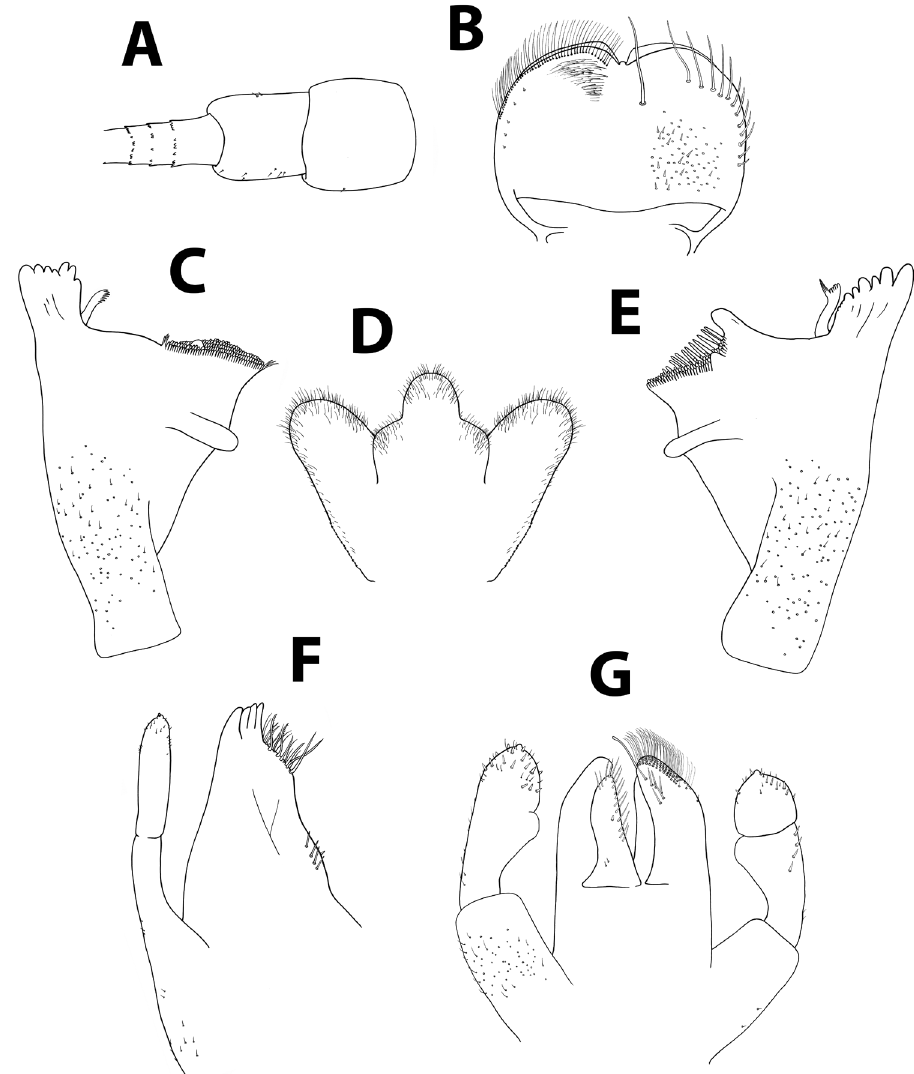
Figure 14. Baetis pacis sp. n., nymph. A antennal scape, pedicel and first flagellomeres B labrum (left, ventral; right, dorsal) C right mandible D hypopharynx E left mandible F maxilla G four rows of long, simple setae; labial palpus 3-segmented; segment I similar in length to segments II and III combined; segment II with distolateral protuberance slightly developed, and dorsal row of 4–5 long pointed setae; conic segment III symmetrical, with apical distinct nipple, covered with needle-shaped blunt setae. Thorax. Forelegs (Figure 15A): coxae almost bare. Trochanters with few ventral minute, stout setae. Femora with one or two dorsal rows with total of ca. 40 stout setae, no longer than 1/4 of femur width, denser proximally; ventral row of ca. 20 minute,